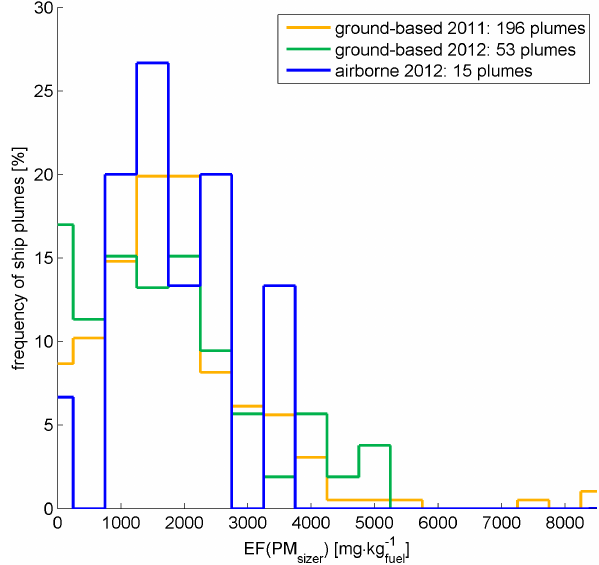
Figure 9. Frequency distribution of emission factors for particle mass. The data bases on the particle sizer measurements from the EEPS and the OPS. The size distribution of the OPS was trun- cated for size channels below 560nm i.e., the upper size limit of the EEPS. Since no more data is available at this stage, the particles are assumed to be of spherical shape with a density of 1gcm − 3